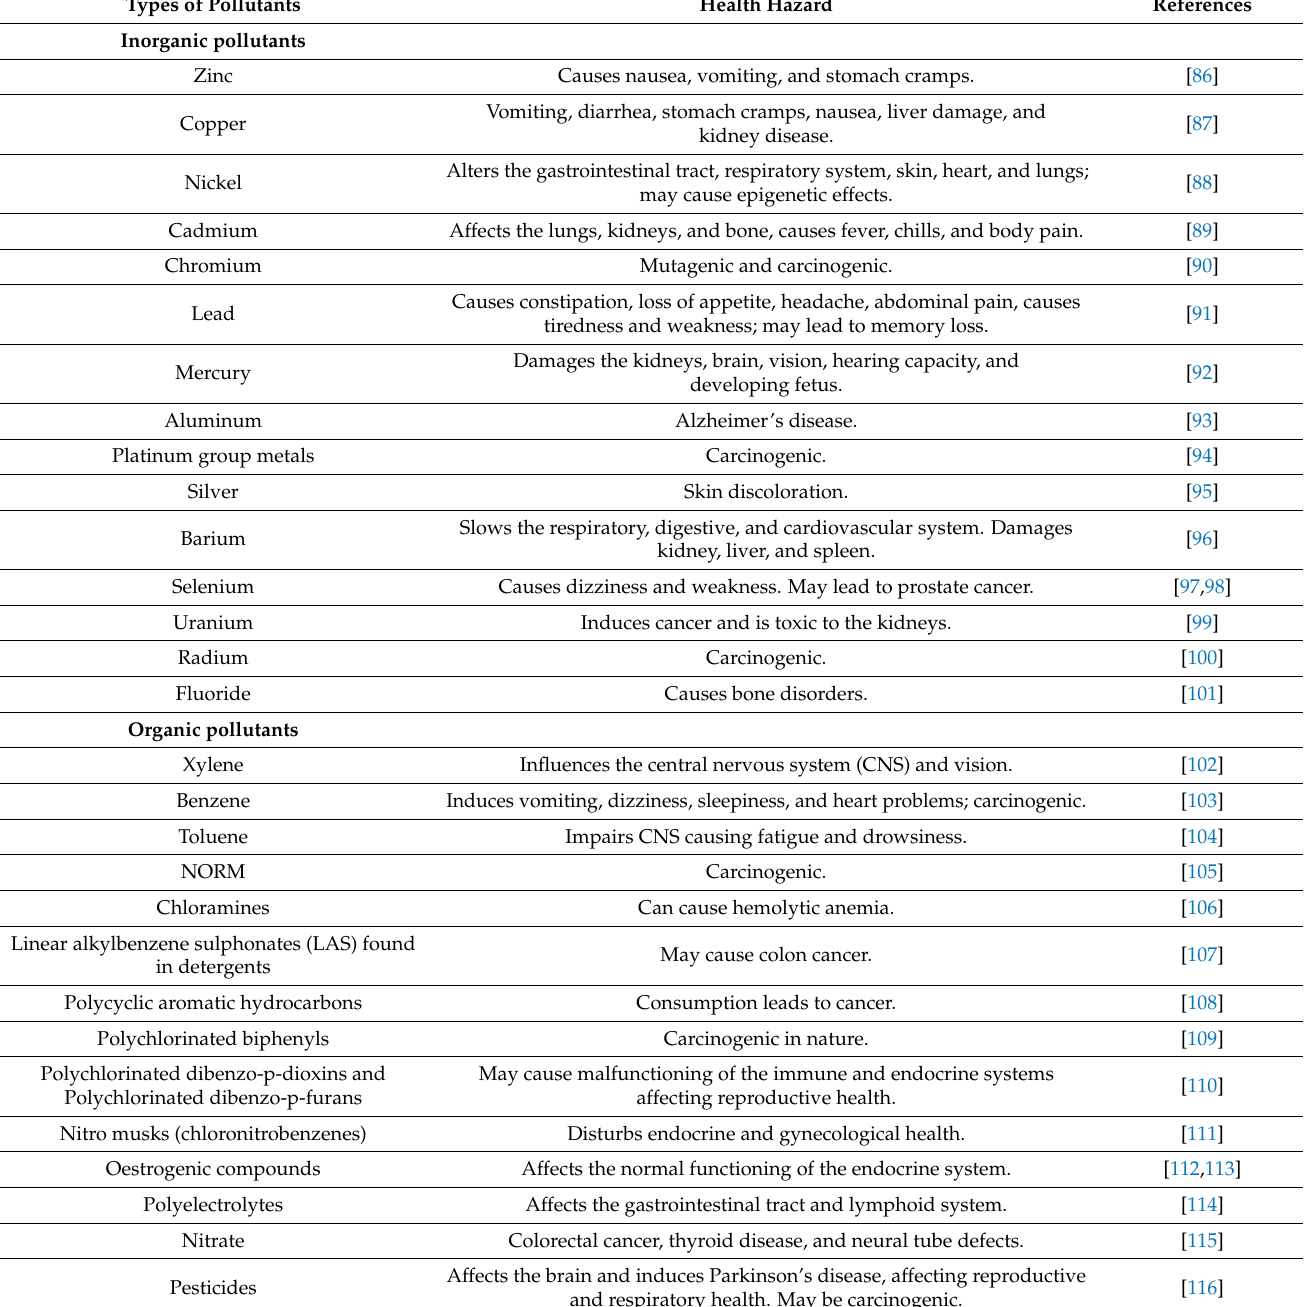
Table 3. Hazardous health effects caused due to consumption of pollutants via